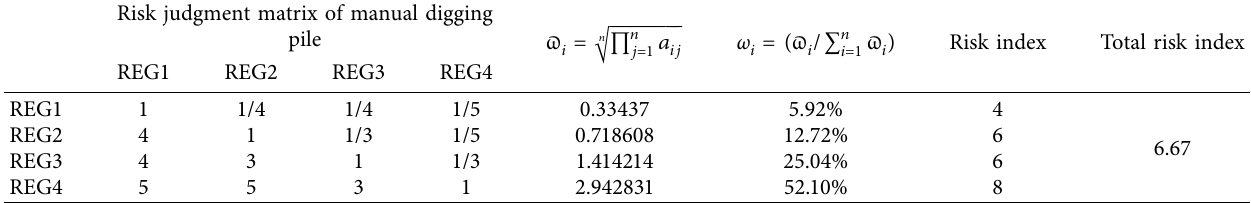
Table 25: Risk judgment matrix of manual hole digging pile.